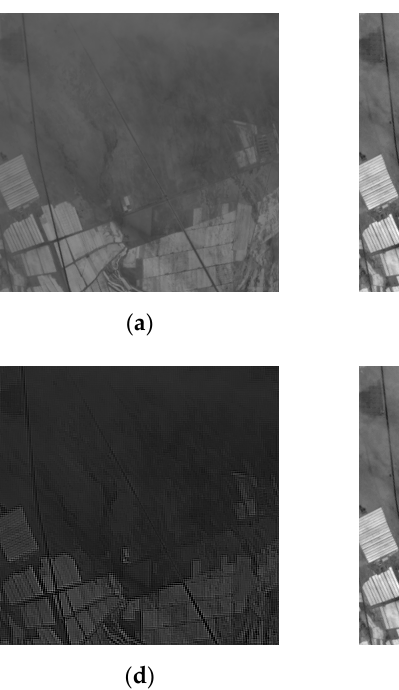
Figure 2. Comparison of different algorithms to clouds: ( a ) original image (real cloud image 1); ( b ) improved homomorphic filtering algorithm (IHF); ( c ) improved retinex algorithm (IR); ( d ) SWT + DWT algorithm (SD); ( e ) Mallat algorithm (M); ( f ) proposed method.